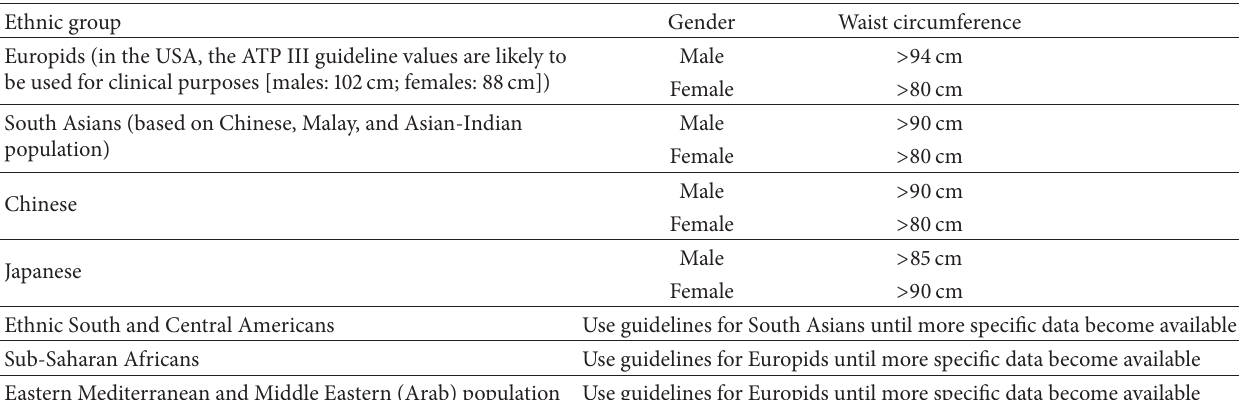
Table 2: Ethnic specific threshold guidelines for waist circumference.